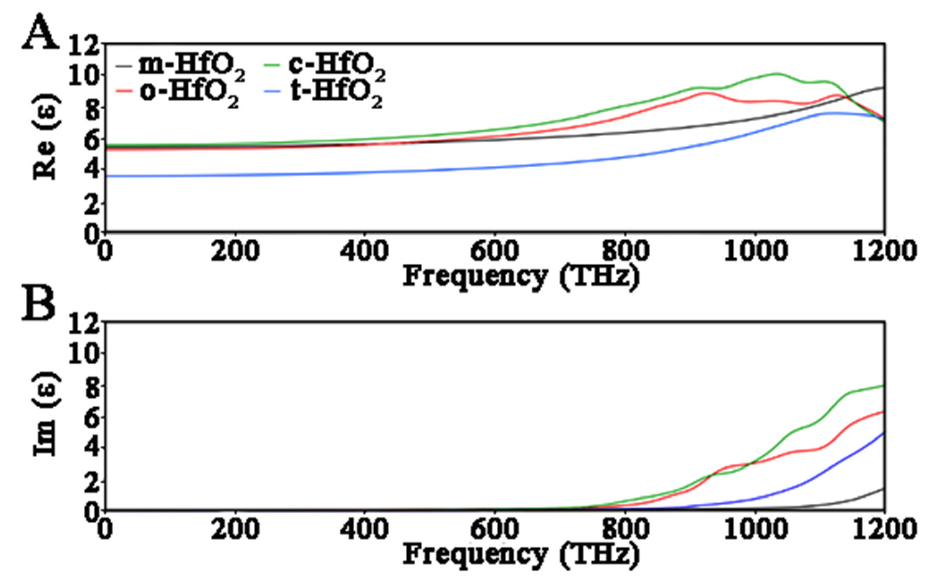
Figure 6. Real part ε 1 ( A ) and imaginary part ε 2 ( B ) of dielectric function for HfO 2 in function of frequency. These data have been obtained using the GGA-PBE + U approach.